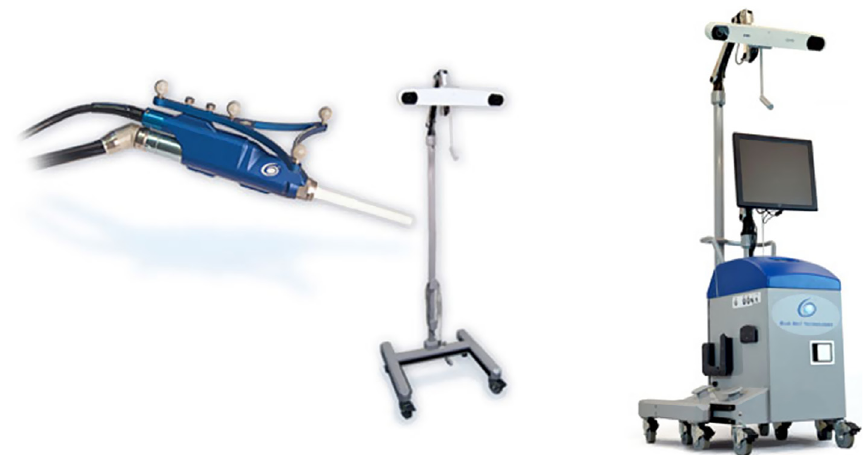
Figure 3. NAVIO robot with hand held precision sculpting